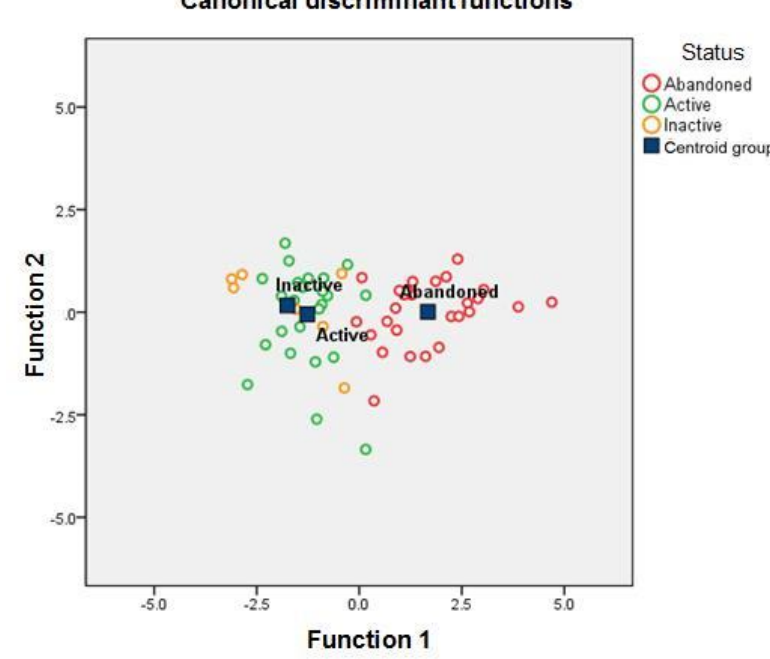
Figure 3. Distribution of the centroids for Bolson tortoise burrows during the summer Table 2. Discriminant canonical function 1 scores with relation to burrow entrance width (W), height (H), air temperature inside the burrow (T relative humidity outside (RH